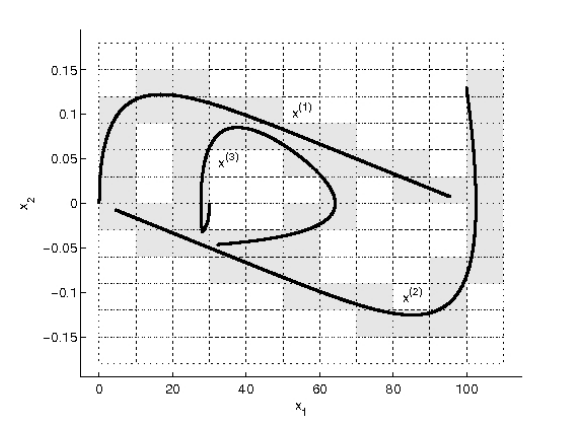
Figure 5. Trajectories x (1) , x (2) , x (3) and elements of the space covered by the test set T X [10 , 0 . 03]